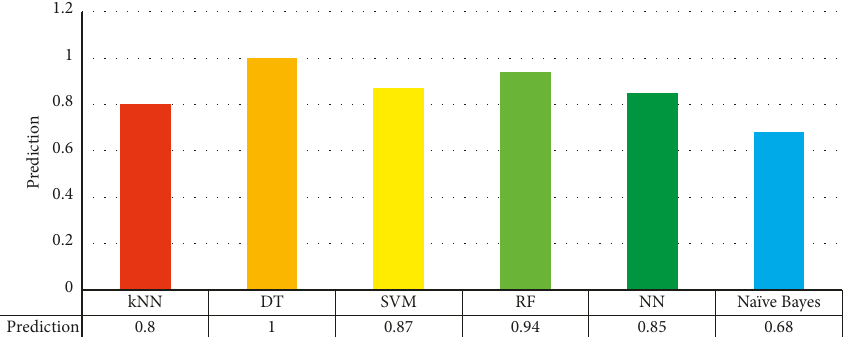
Figure 16: Graphical presentation of prediction of high noise level using different ML models for the input instances with probability values